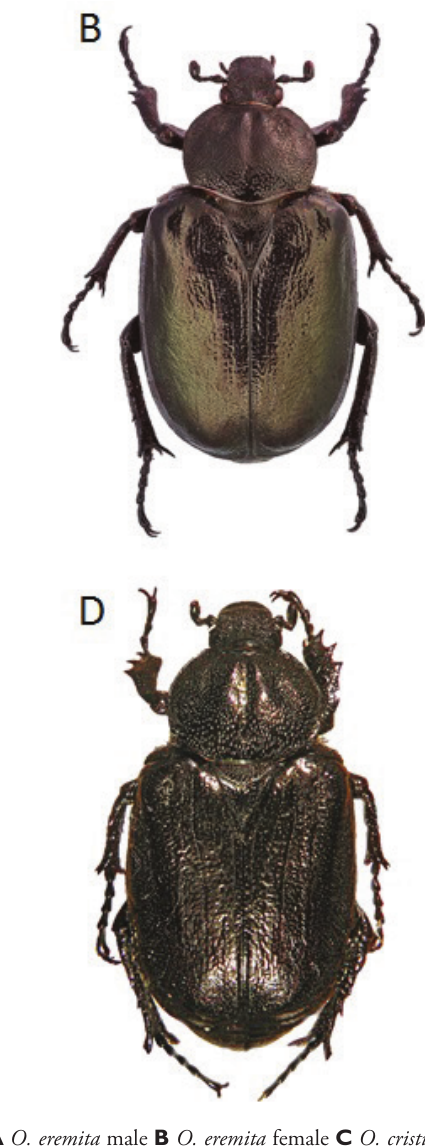
and short tarsi. Fore tibiae have three distinct teeth on their external side. The wings are well developed in both sexes. Colour is black to piceus or chestnut, often shiny with cupreous or green metallic